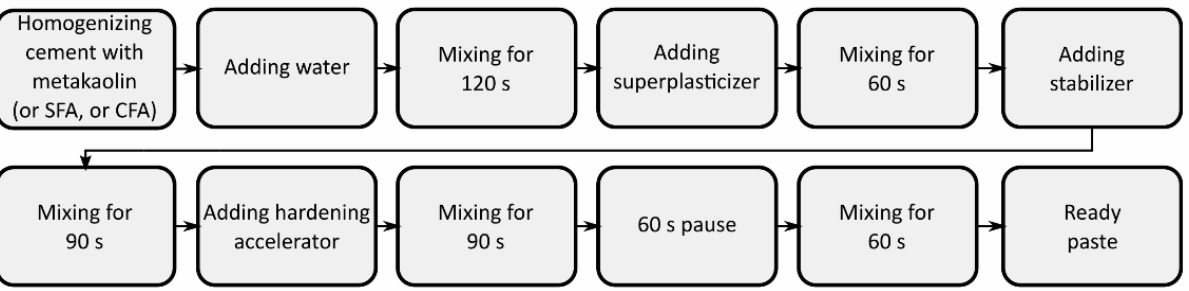
Figure 2. Preparation of the